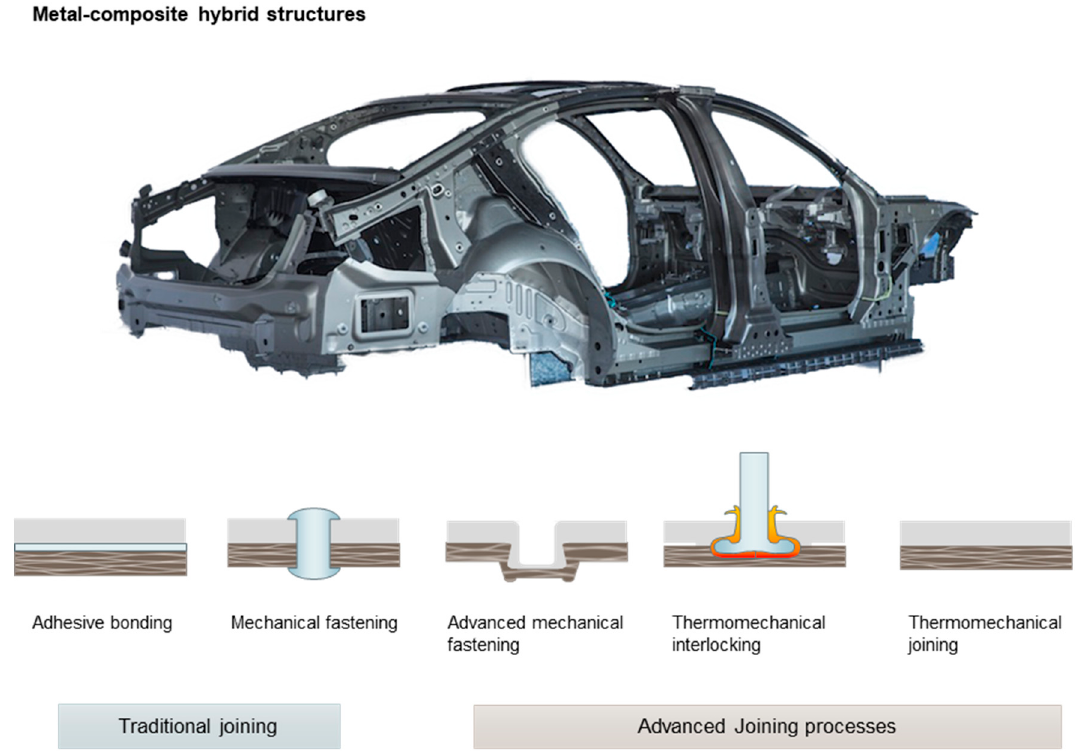
Figure 1. Major joining processes for hybrid metal-composite structures.